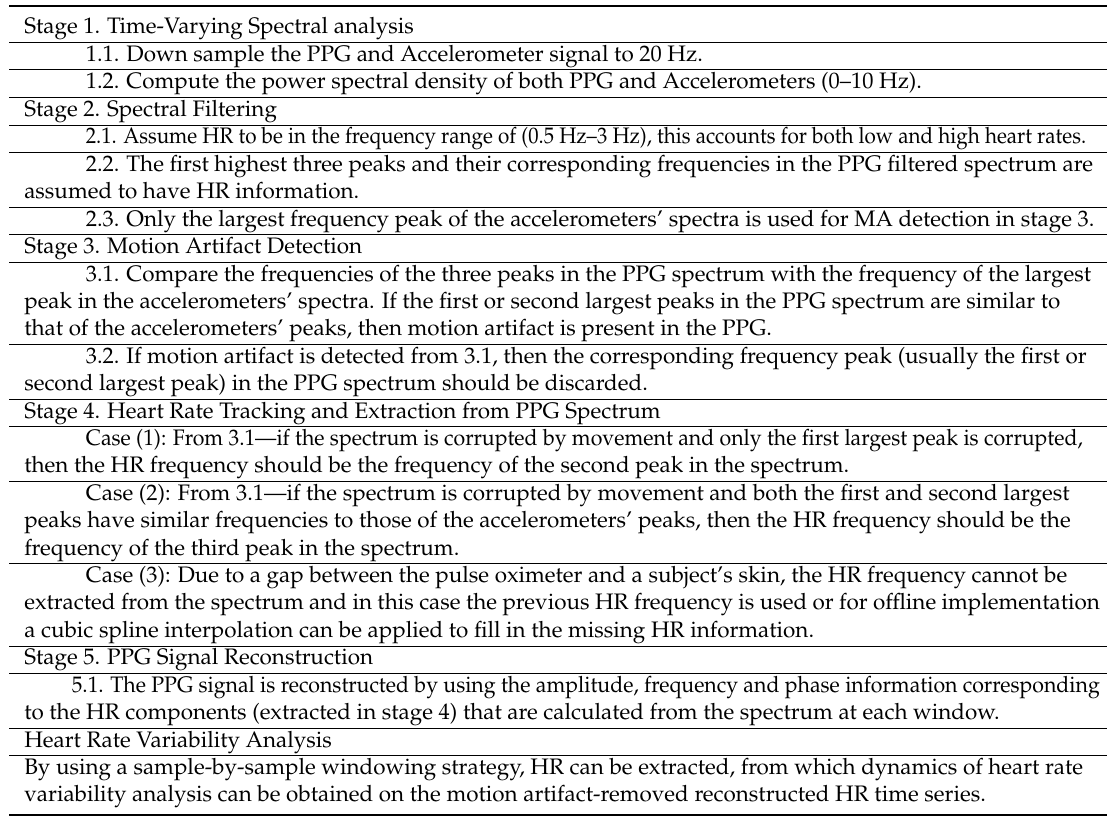
Table 2. The proposed SpaMA algorithm: HR and PPG signal